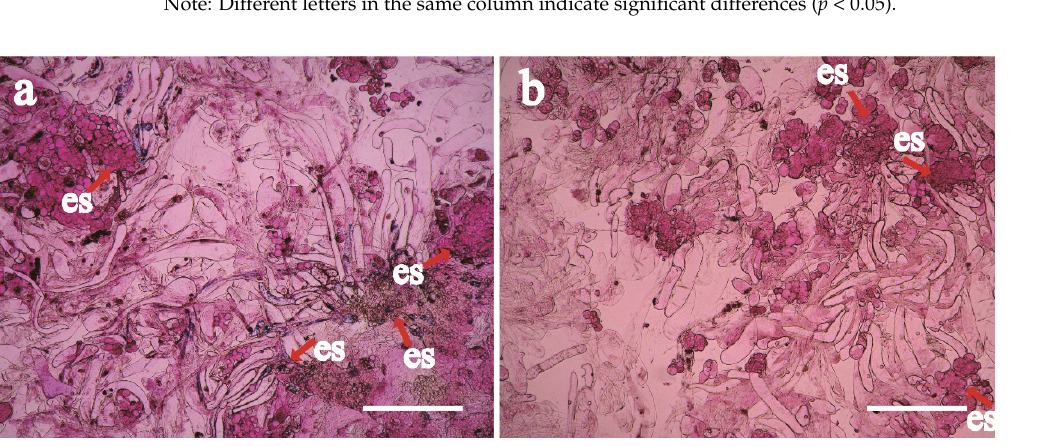
Figure 4. Effects of maltose and sucrose as carbohydrate sources on the development and maturation of Korean pine somatic embryos. ( a ) The proliferation of ECs cultured with maltose as a carbon source. Scale = 50 µ m. ( b ) The proliferation of ECs cultured with sucrose as a carbon source. Scale = 50 µ m. The letters es represent early somatic embryos.